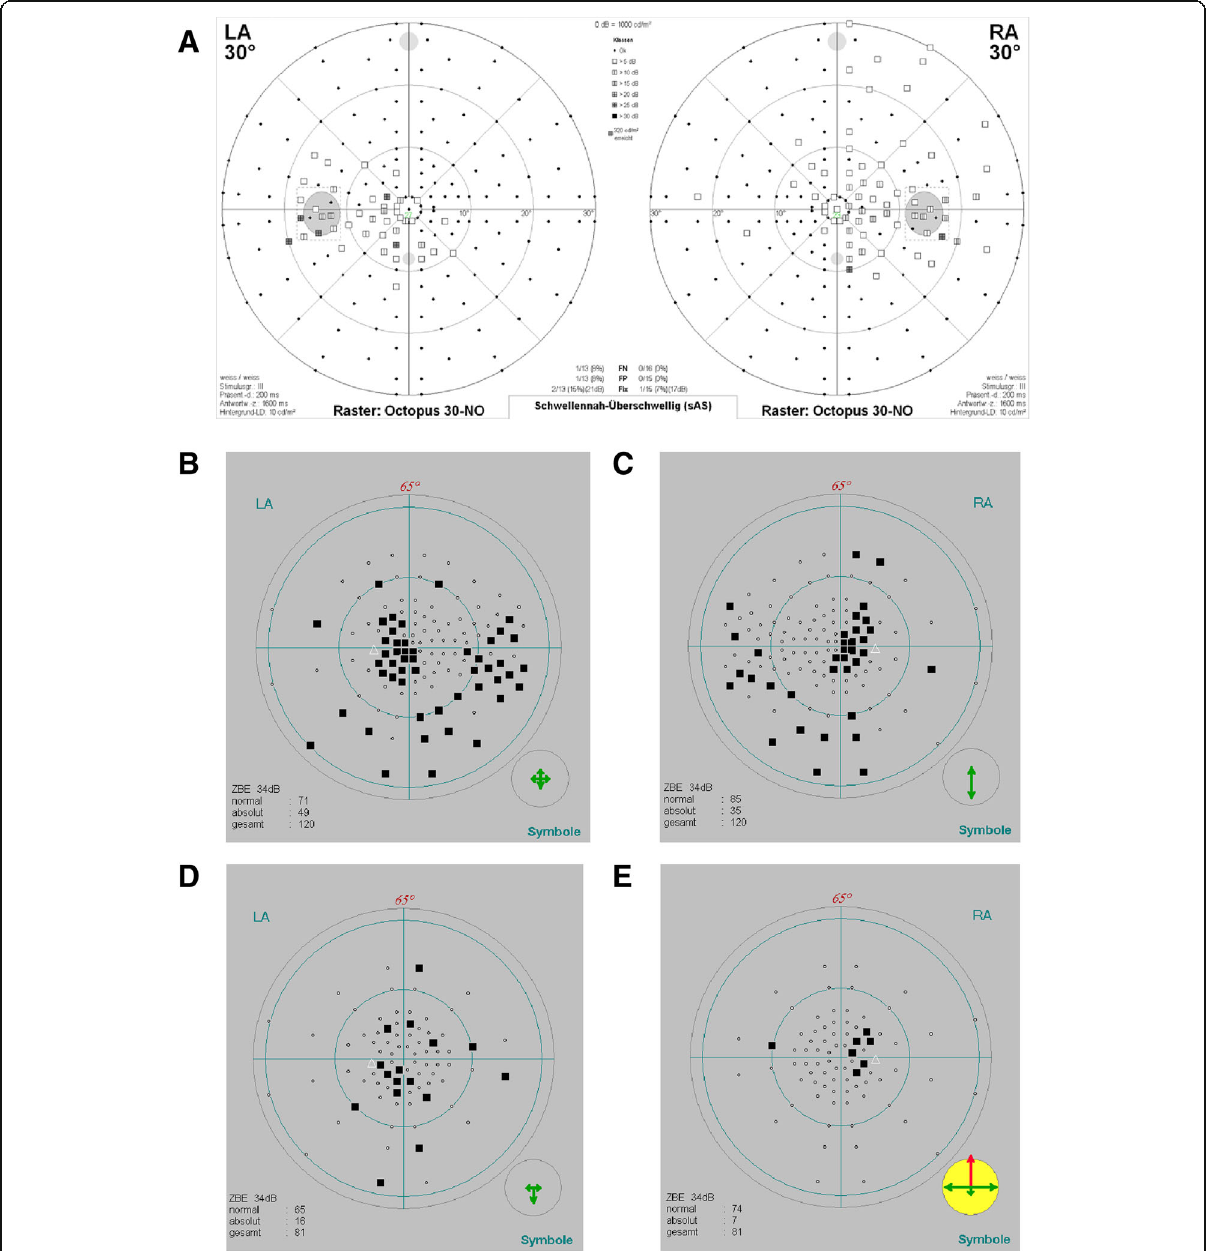
Fig. 4 Perimetry. a The right and left eye visual fields are represented for the affected proband in family A (II:1) and exhibit central scotomas. Scotomas can also be seen in the affected sister ( b - c ; II:1) and her brother ( d - e ; II:2) of family B, with the sister showing a more pronounced